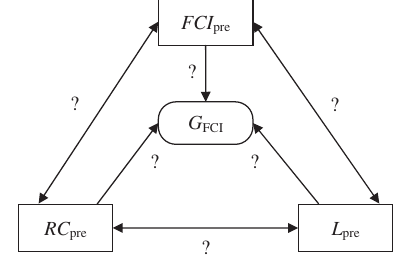
FIG. 1. The correlations between single student normalized FCI gain ( G FCI ) and the three pretest variables: representational consistency on the R-FCI pretest ( RC pre ), the FCI prescore ( FCI pre ), and the Lawson prescore ( L pre